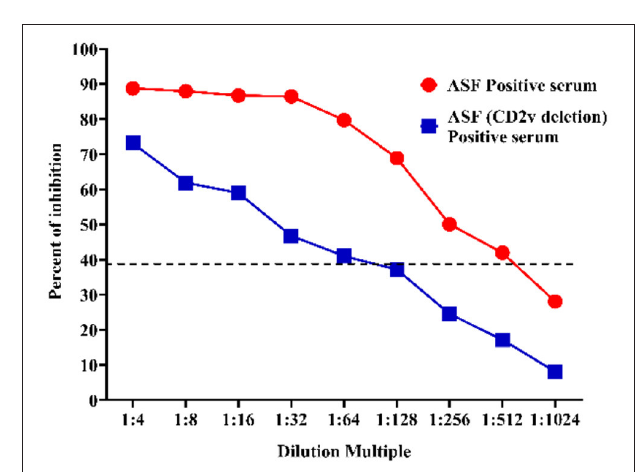
FIGURE 6 | Sensitivity assay. The ASFV-positive standard serum (Red) and the ASFV-positive standard serum against CD2v-negative (Blue) at different dilutions were titrated with 2-fold dilutions from 1:4 to 1:1,024. The dashed line represents the cut-off of blocking